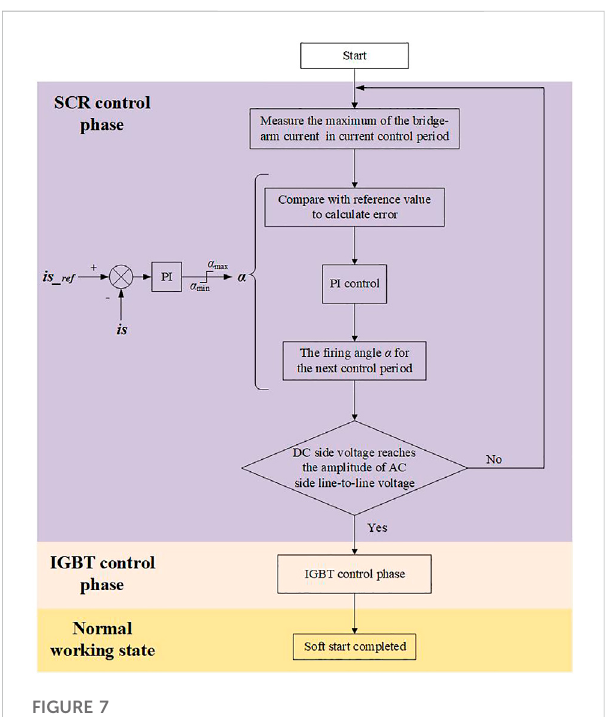
FIGURE 7 Flow chart of the dynamic control strategy of fi ring